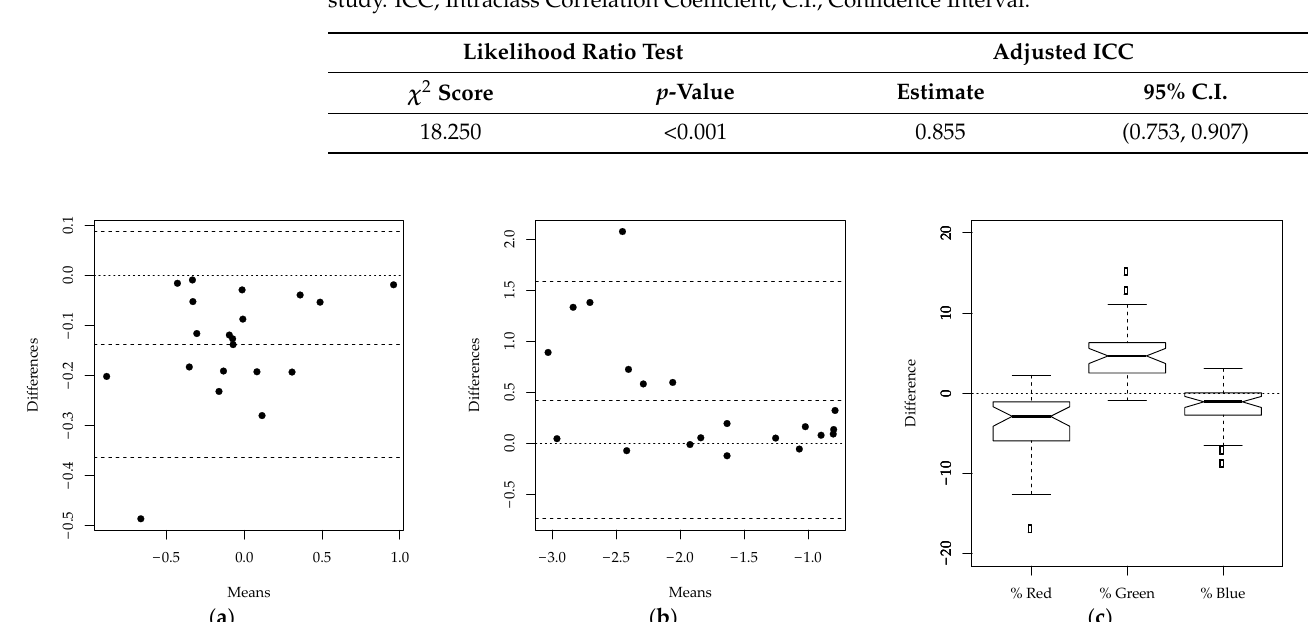
Figure 5. Interobserver reproducibility study: ( a ) Bland-Altman plot—First dimension of isometric log ratio transformed data; ( b ) Bland-Altman plot—Second dimension of isometric log ratio transformed data; ( c ) Boxplots of the differences between the measurements of AC and VS for each color channel.